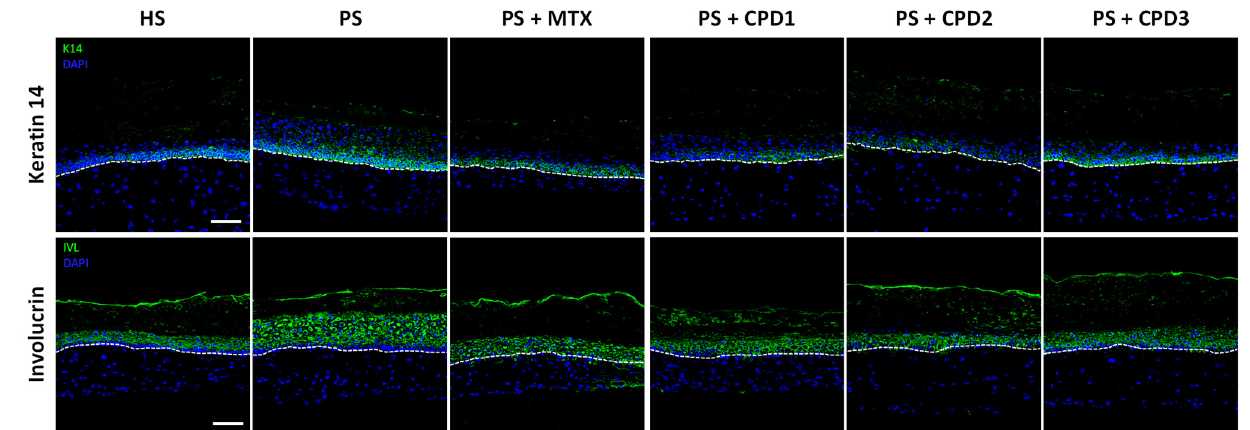
Figure 4. Immunofluorescence staining of early differentiation markers (green). Expression of keratin 14 (K14) and involucrin (IVL) in healthy substitutes (HSs); psoriatic substitutes (PSs); and psoriatic substitutes treated with methotrexate (MTX), quebecol (CPD1), ethyl 2,3,3-tris(3-hydroxy-4- methoxyphenyl)propenoate (CPD2) and bis(4-hydroxy-3-methoxyphenyl)methane (CPD3). Nuclei were stained with Hoechst (blue). The dotted white line represents the dermo-epidermal junction. Scale bars: 50 μ m. Each staining is representative of three different cell populations.